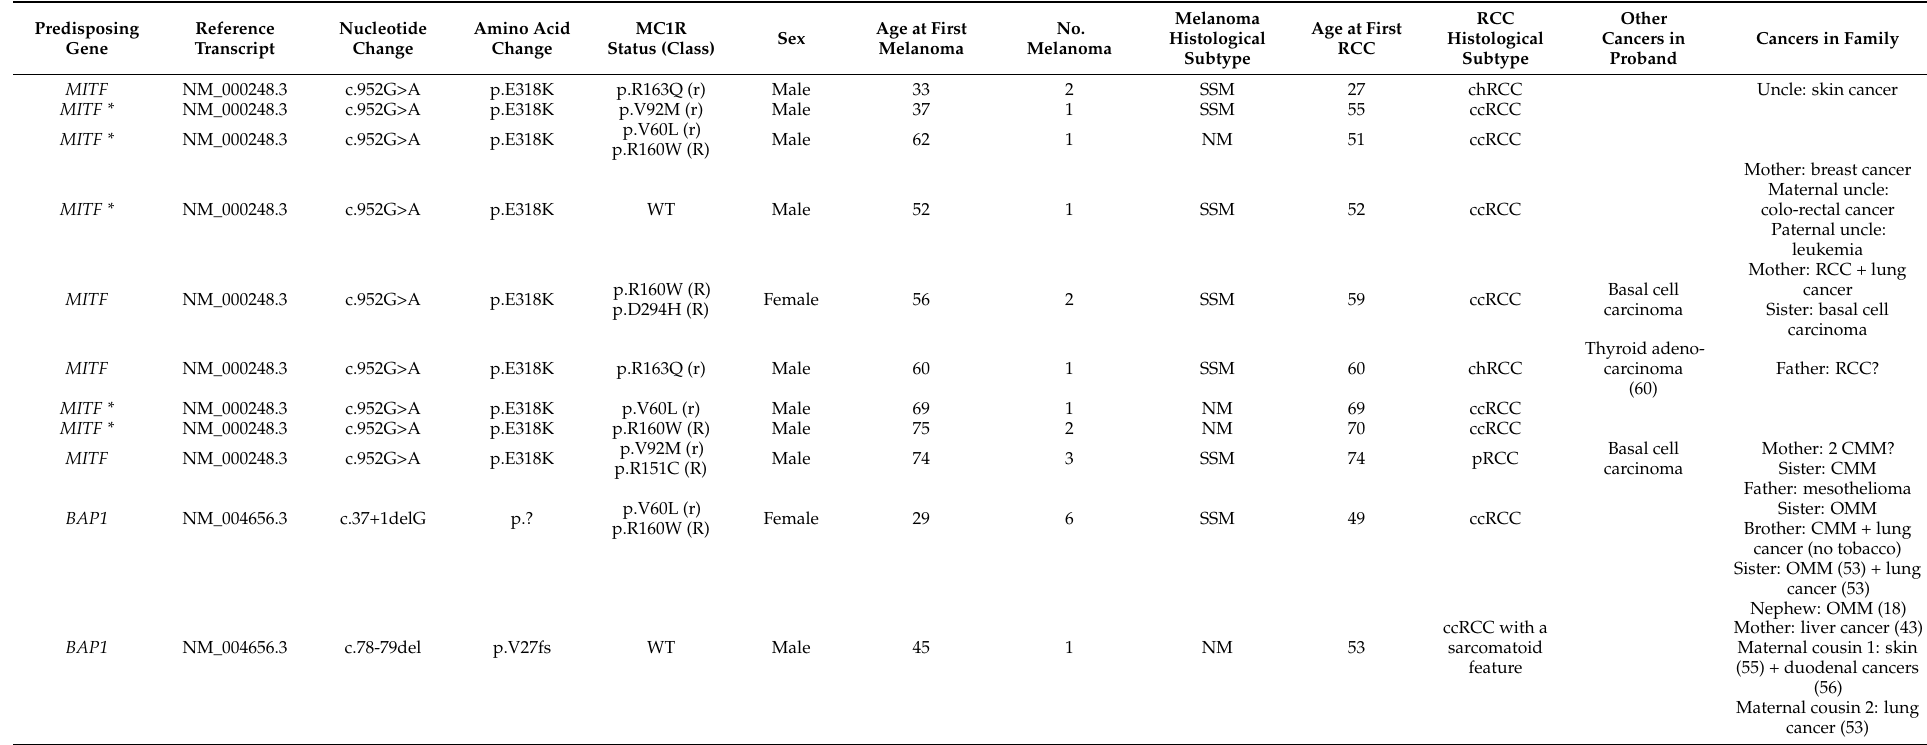
Table 2. Characteristics of the 17 patients with pathogenic variants in known melanoma and/or RCC predisposing